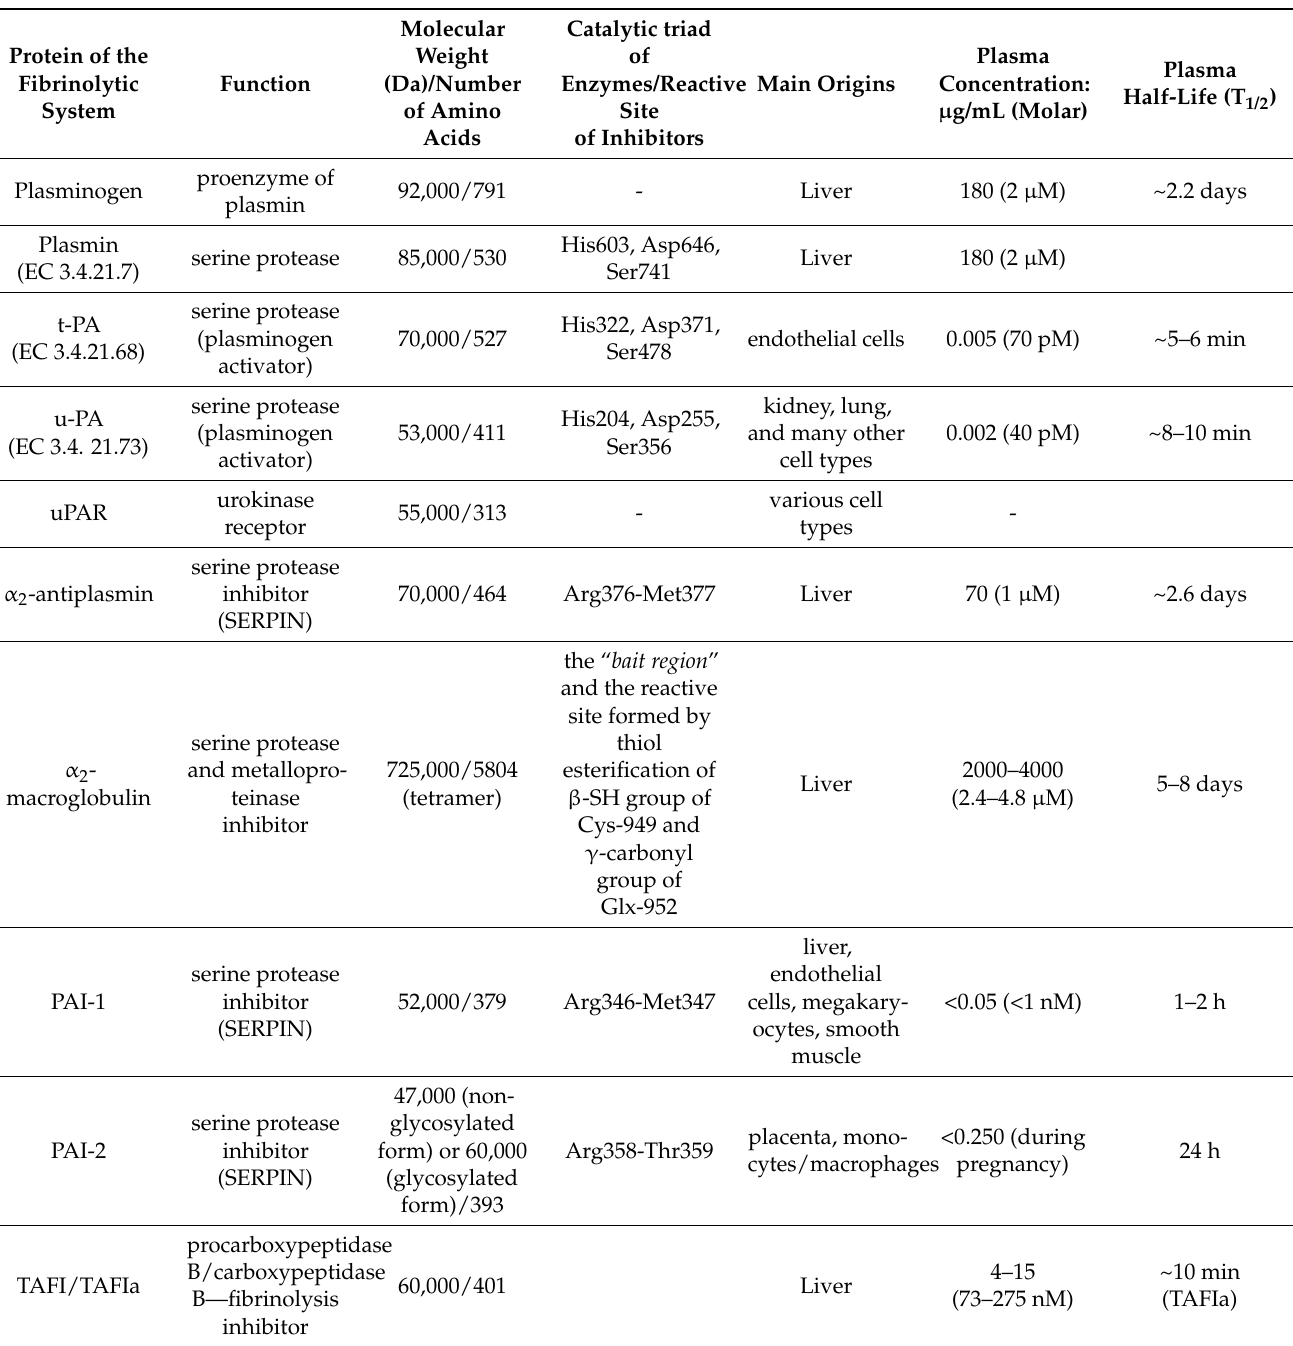
Table 1. General characteristics of main proteins of the fibrinolytic